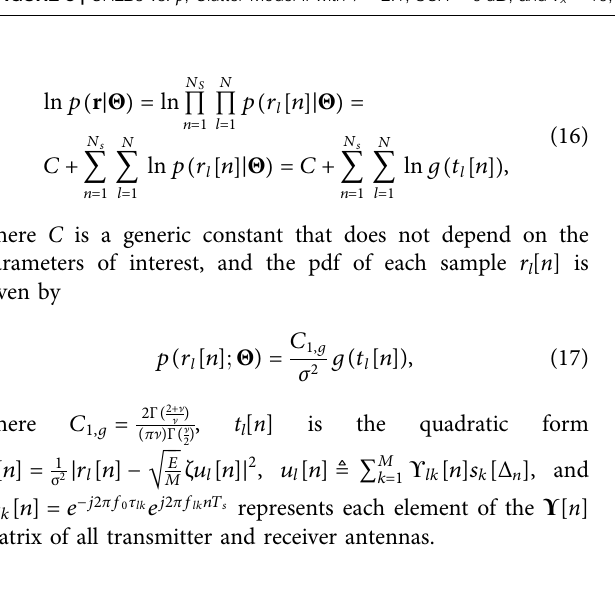
FIGURE 8 | CRLBs vs. ρ , Clutter Model II with ] = 2.1, SCR = 0 dB , and v x = 10, v y = 35 m/s.